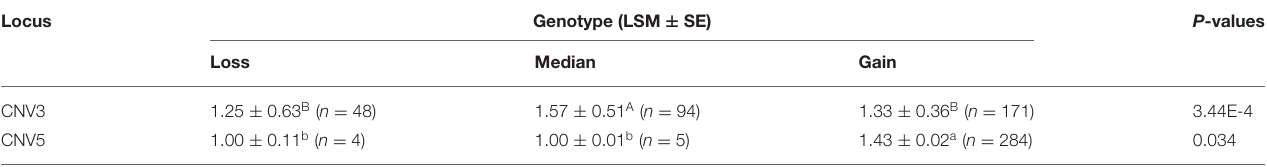
TABLE 5 | Association analyses between litter size and copy number variation types in Shaanbei white cashmere goats. Locus